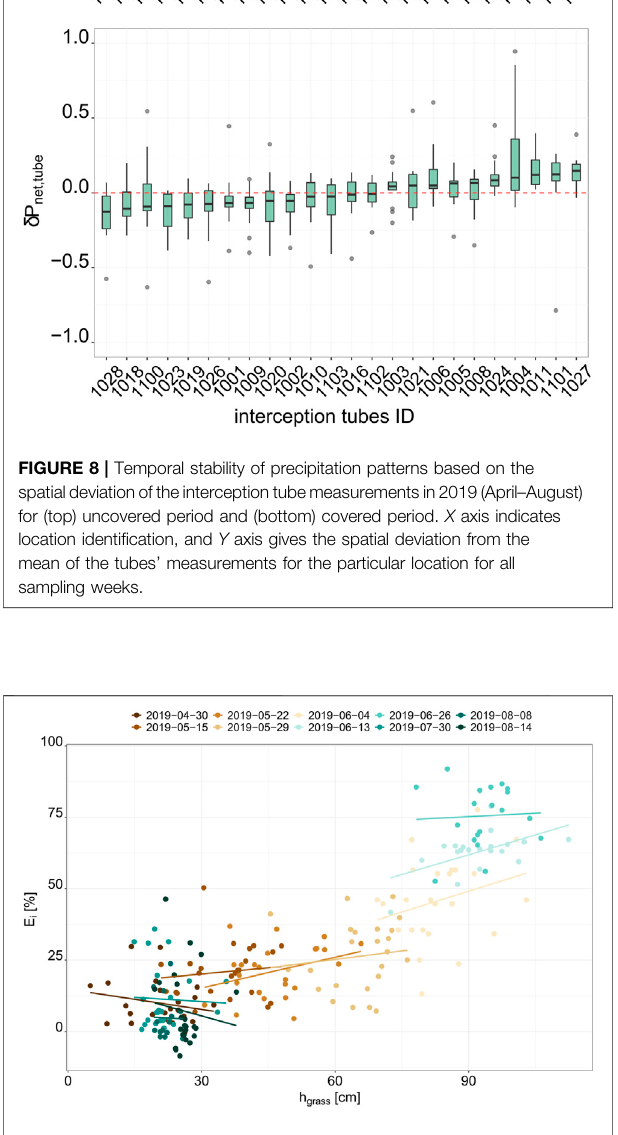
FIGURE 9 | Relation between cumulative weekly interception loss (E i ) and grass height (h grass ). Each point stands for one location. Measurement weeks are differently coloured.